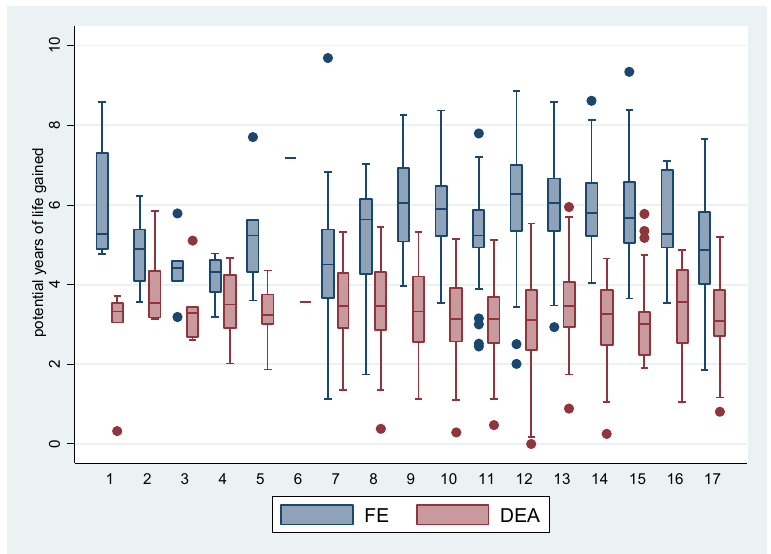
Figure 1. Dispersion of the impact on Life Expectancy at Birth, denoted by the potential years of life gained: contrasts between methods (FE and DEA), according to the Regionalized Healthcare Networks (RRAS). Note: The municipalities with the highest potential gains are Santos (RRAS 7), Nova Odessa (RRAS 15) and Bady Bassit (RRAS 12) and the benchmark municipalities are Eldorado (RRAS 7); Itapirapuã Paulista (RRAS 8) and Jambeiro (RRAS 17), as they express higher average levels of effectiveness and efficiency. RRAS: Greater SP (1. ABC, 2. Alto Tietê,3. Franco da Rocha, 4. Mananciais, 5. Rota dos Bandeirantes and 6. Capital); 7. Registro and Santos; 8. Sorocaba; 9. Bauru; 10. Marília; 11. Presidente Prudente; 12. Araçatuba and São José do Rio Preto; 13. Ribeirão Preto and surroundings; 14. Piracicaba; 15. Campinas and São João da Boa Vista; 16. Campinas (Bragança and Jundiaí) and 17. Taubaté.